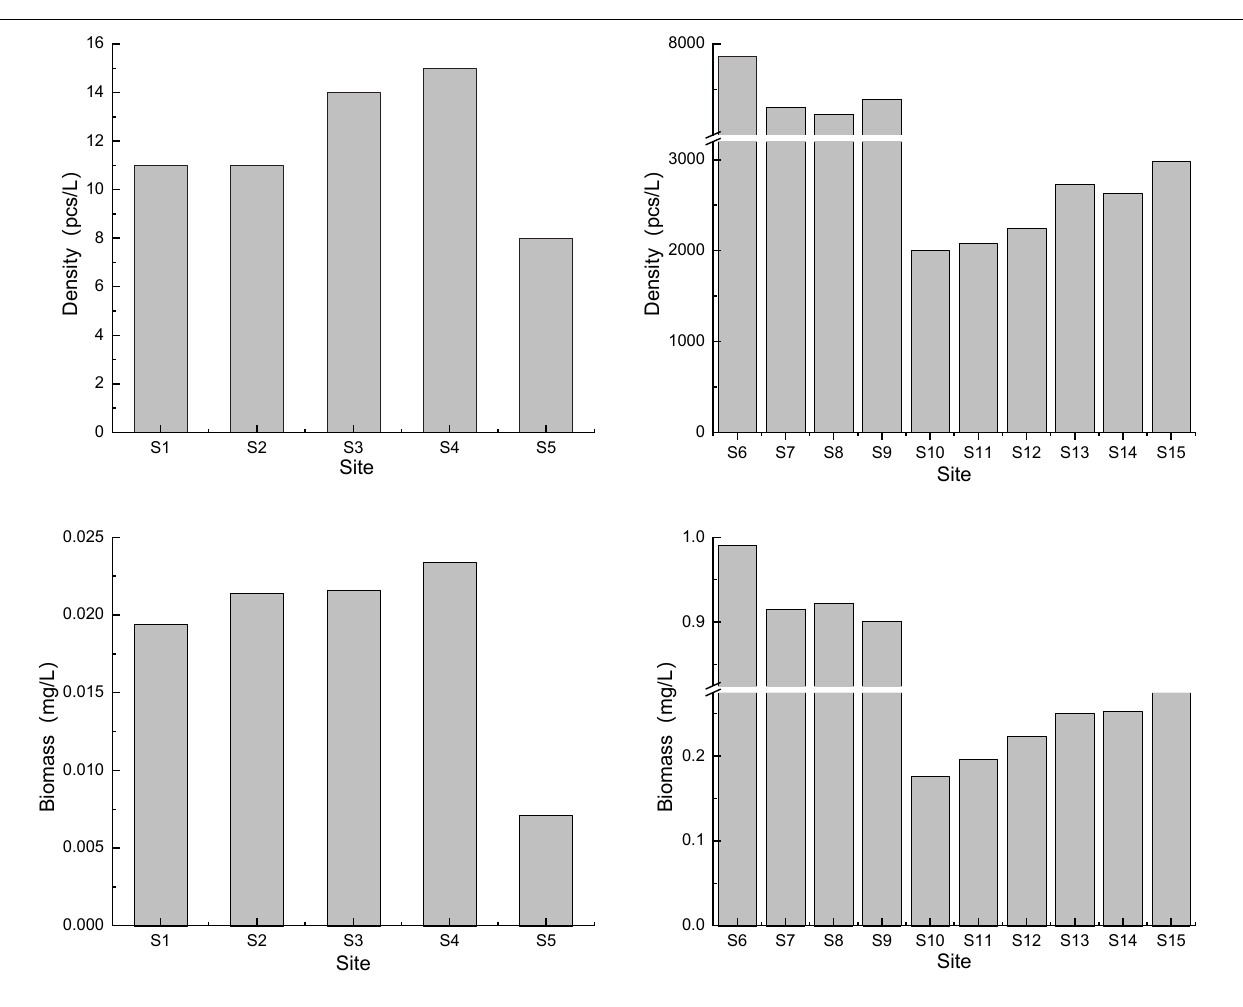
FIGURE 4 | Spatial distribution of phytoplankton density and